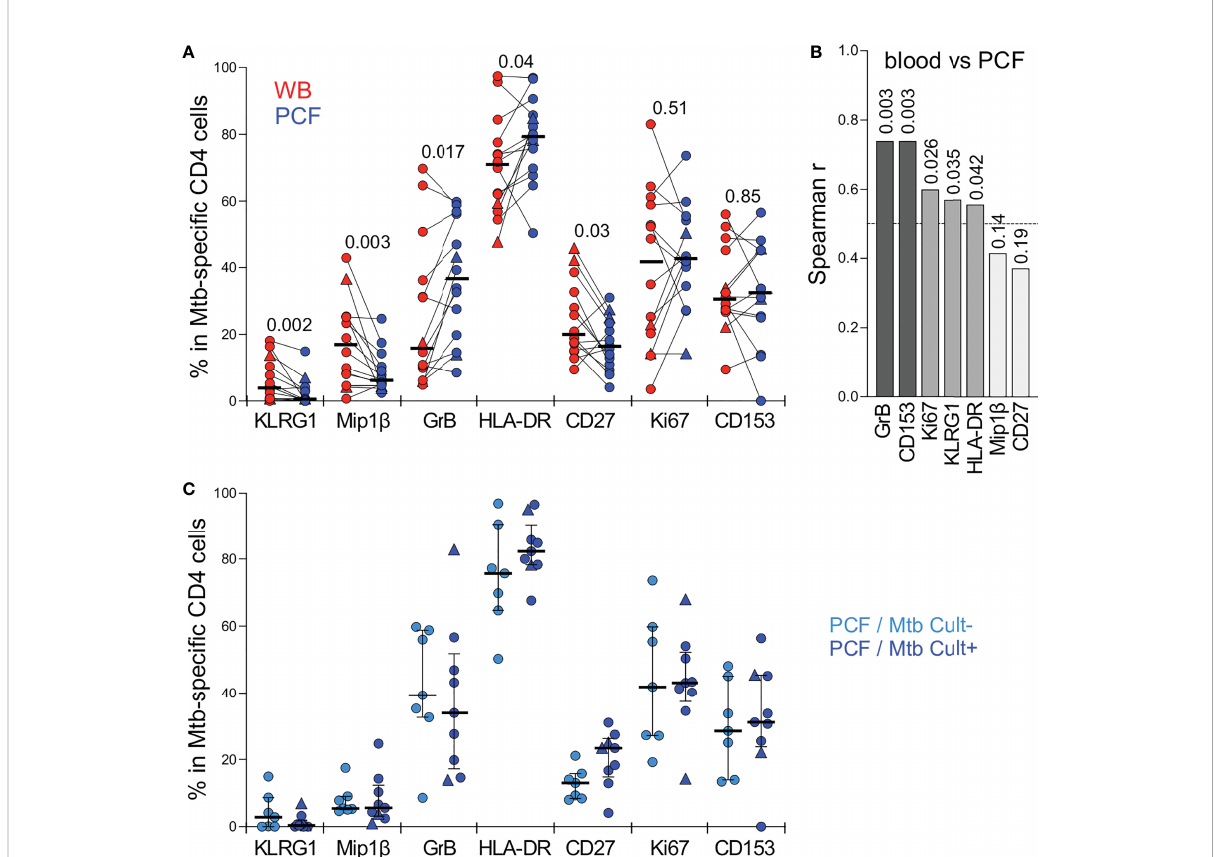
FIGURE 4 Comparison of the phenotypic pro fi le of Mtb-speci fi c CD4 T cells in blood and PCF. (A) Expression of GrB, CD27, HLA-DR, Ki67, KLRG1, CD153 and MIP1 b in Mtb-speci fi c CD4 T cells (i.e. producing any measured cytokine IFN g , IL-2, and TNF a ). Only paired samples with Mtb-speci fi c responses >30 events are depicted (n=14). Bars represent medians. The triangles depict HIV-uninfected participants (n = 2). Statistical comparisons were performed using a Wilcoxon rank test. (B) Spearman correlation r values between indicated Mtb-speci fi c CD4 T cell phenotype in blood and PCF. P values are indicated for each comparison. (C) Comparison of the phenotypic pro fi le of Mtb-speci fi c CD4 cells from PCF between patients who are PCF Mtb culture negative (PCF/Mtb Cult-, light blue, n=7) or PCF Mtb culture positive (PCF/Mtb Cult+, dark blue, n=9). Bars represent medians. Statistical comparisons were performed using the Mann-Whitney